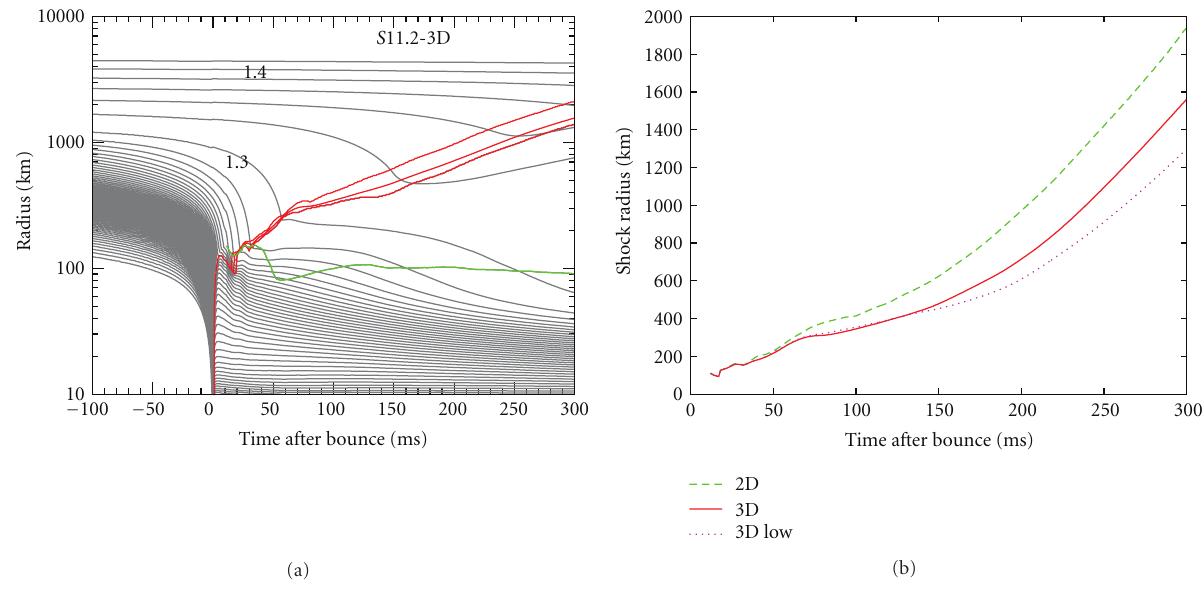
Figure 5: Time evolution of our 3D model [139] visualized by mass shell trajectories in thin gray lines (left panel). Thick red lines show the position of shock waves, noting that the maximum (top), average (middle), and the minimum (bottom) shock position are shown, respectively. The green line represents the shock position of the 1D model. “1.30” and “1.40” indicate the mass in unit of M (cid:3) enclosed inside the mass-shell. Right panel shows the evolution of average shock radii for the 2D (green line) and 3D (red line) models. The “3D low” (pink line) corresponds to the low resolution 3D model, in which the mesh numbers are taken to be half of the standard model (see text). These figures are taken from [139].